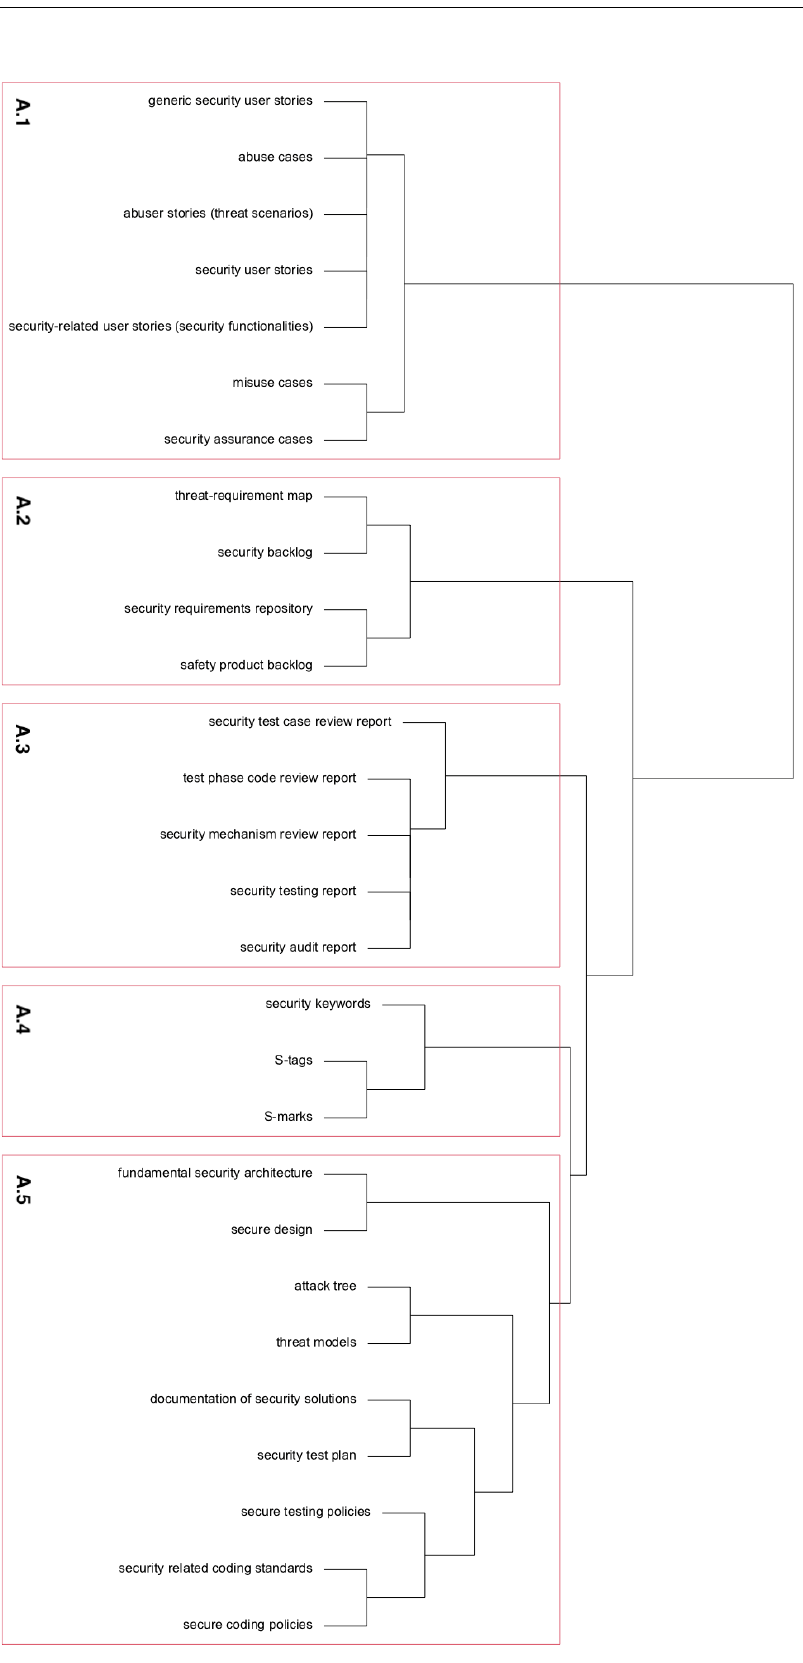
Figure 2. Dendrogram of artifacts. It indicates five distinct clusters: security requirement artifacts (A.1), security repositories (A.2), security reports (A.3), security tags (A.4), and security policies